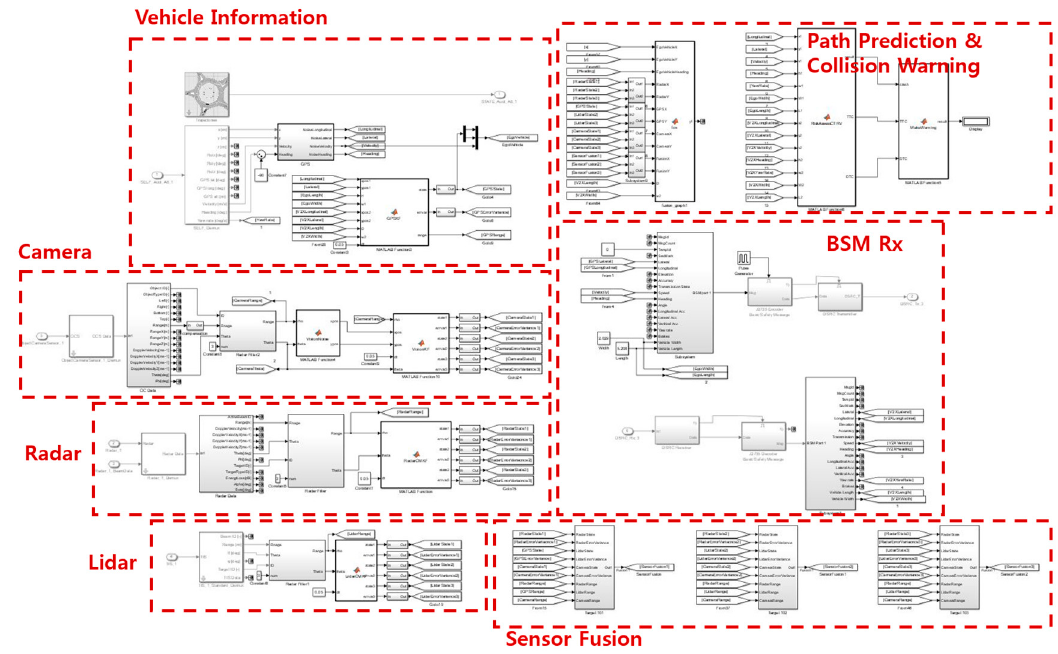
Figure 6. Simulink blocks and subsystems designed for the proposed vehicle collision warning system.